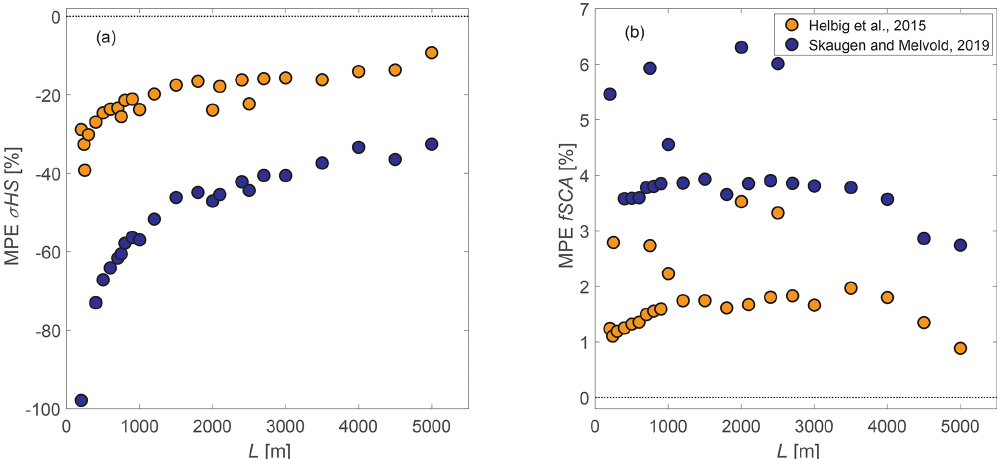
Figure 12. Mean percentage error (MPE) as a function of L for the compiled data set for (a) σ HS and (b) fSCA. MPEs are shown for the σ HS and fSCA parameterizations of Helbig et al. (2015), as well as for the σ HS parameterization of Skaugen and Melvold (2019) and the σ HS parameterization of Skaugen and Melvold (2019) applied in the fSCA parameterization of Helbig et al. (2015) (Eq.